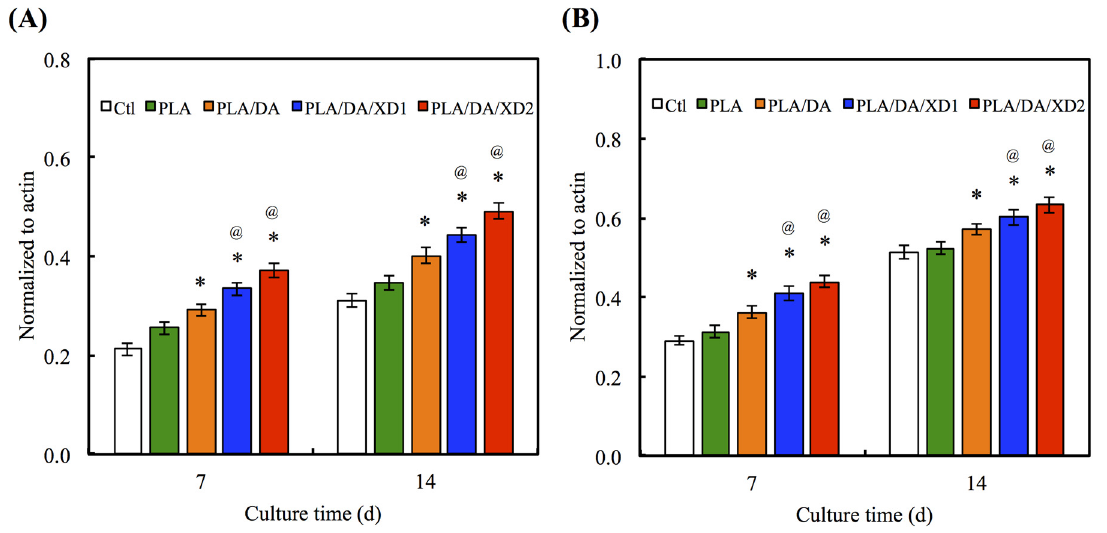
Figure 11. The protein expression of ( A ) Ang-1 and ( B ) vWF of hBMSCs cultured on scaffolds for different days. The values shown are means ± standard errors for all the assays. “*” indicates a significant difference ( p < 0.05) compared to PLA; “@” indicates a significant difference ( p < 0.05) compared to